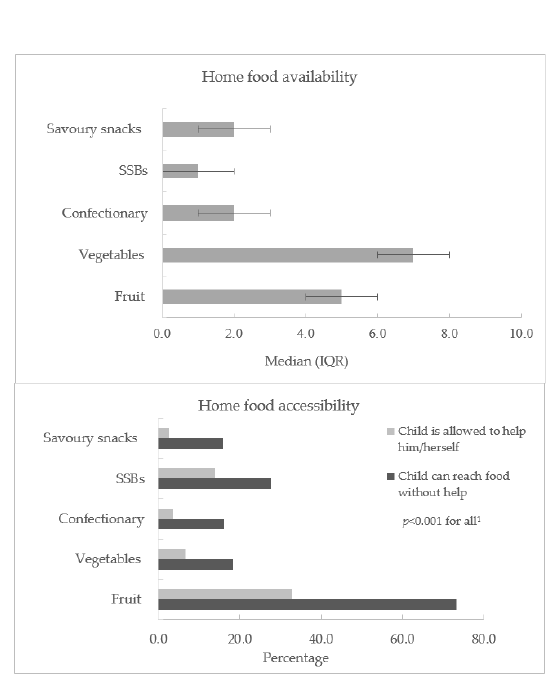
Figure 1. Home food availability and accessibility. IQR: Interquartile range; SSB: sugar-sweetened beverage; 1 Association between food accessibility variables assessed using the chi-squared test with Yates’ Continuity Correction for 2 × 2 contingency tables.